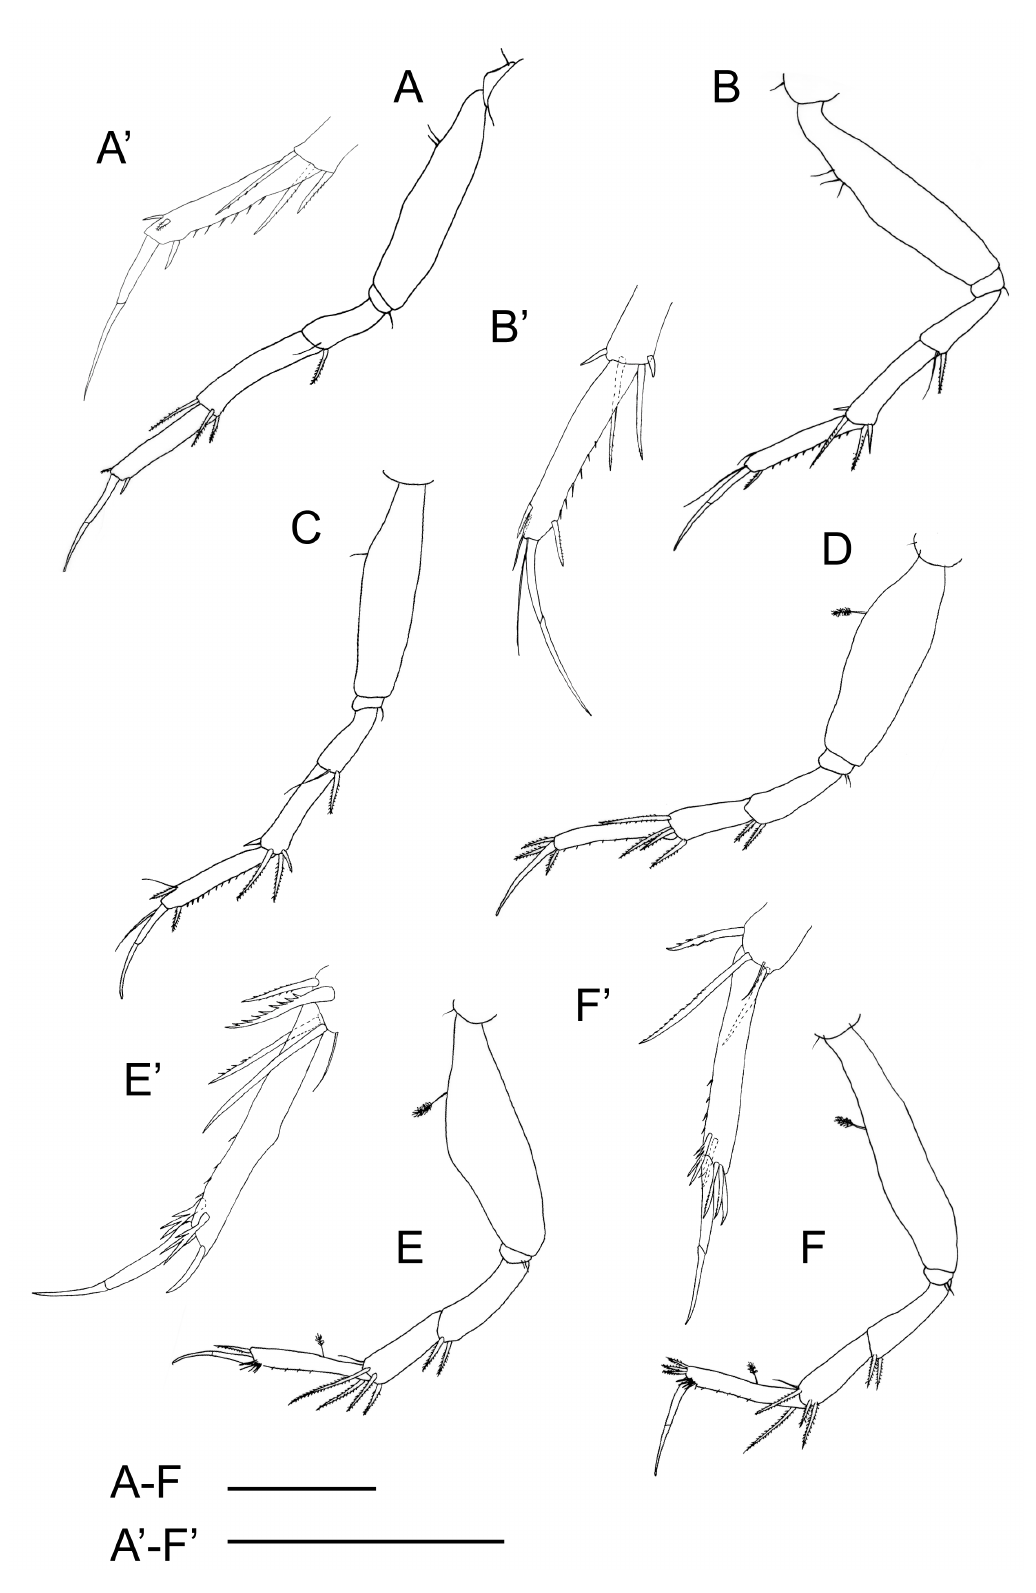
Fig. 8. Tirana vallis gen. et sp. nov. Holotype, adult, ♀ (MNCN 20.04/12540). A–F . Pereopods 1–6. A’–F’ . Detail in dactylus and unguis pereopods 1–3, 5 and 6. Scale bars = 100